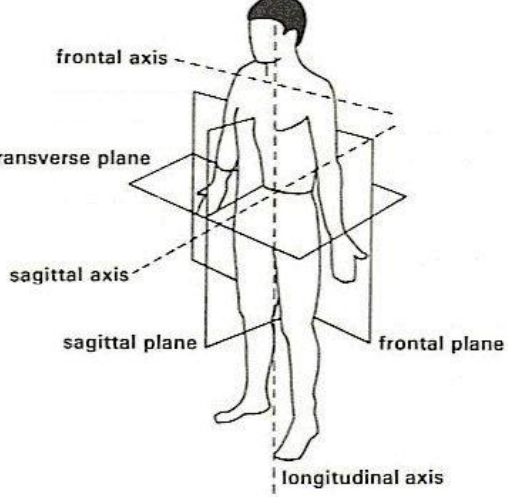
Figure 1. Body planes and axis. Frontal axis is defined along medio-lateral direction; sagittal axis is defined along antero-posterior direction and longitudinal axis is defined along superior-inferior direction.